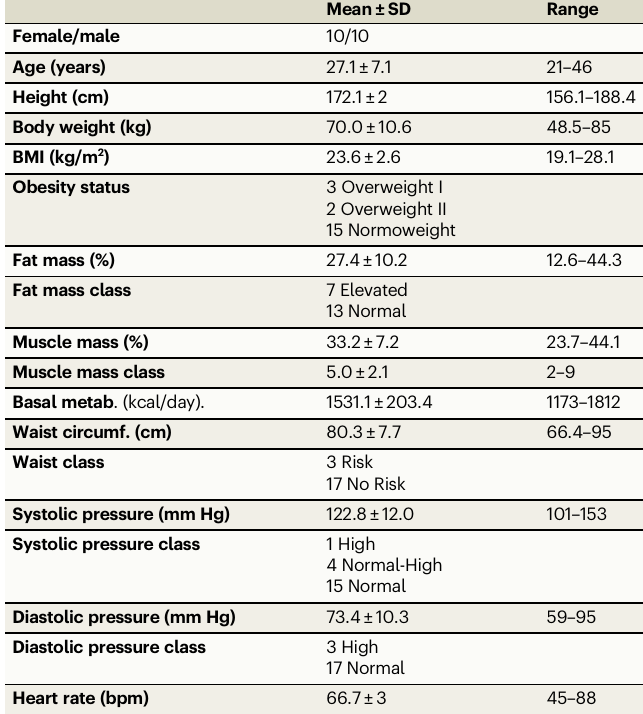
Table 1 | Morphometric and basic cardiovascular data from recruited volunteers Mean±SD